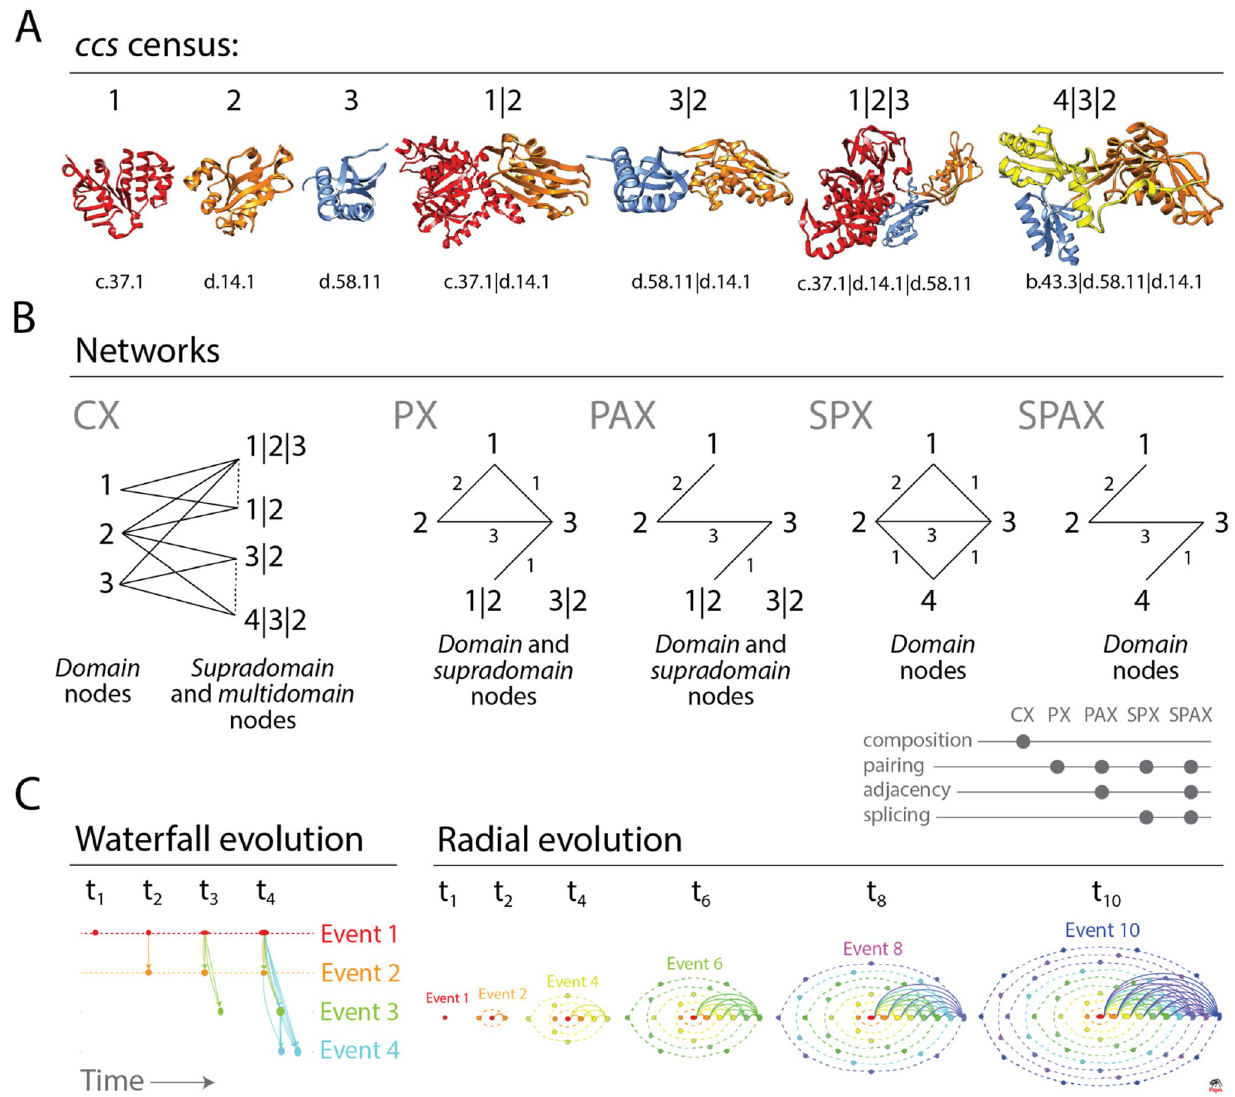
Figure 1. Networks of protein domain organization. ( A ) The genomic census of structural domains and their combinations defines SCOP concise classification string ( ccs ) descriptors of domains, supradomains and multidomains that are building blocks of networks. We illustrate the census with a sample from the entire entity set, comprising of 3 domains (1, 2 and 3), 2 supradomains (1|2 and 3|2) and 2 multidomains (1|2|3 and 4|3|2) that are common in dehydratase enzymes and elongation factors. ccs identifiers of structural domain constituents defined at fold superfamily (FSF) level are listed below the atomic models visualized in ribbon format with Chimera. ( B ) Five operative criteria for network generation capture the interactions among protein architecture nodes as networks grow in evolution. CX is a partial bipartite network (projection-decomposable) that connects domain nodes to supradomain and multidomain nodes (which can connect to each other; hatched links) when present in multidomain proteins. PX connects domain and supradomain nodes when multidomain proteins are ‘decomposed’ into pairs of architectures, regardless of topological constraints. PAX borrows the PX criterion but respects topological constraints. SPX connects domain nodes spliced from architectures when domain pairs are present in proteins. SPAX connects domain nodes when adjacent domain pairs are present in proteins. ( C ) Chronological development of evolving networks. In ‘waterfall evolution’ layout, time progresses from left to right as ‘discrete events’ of network evolution progressively unfold the appearance of nodes and links (time-directed arrows known as arcs) from top to bottom, colored according to their age. Arc multiplicities describe link cardinality. Source-sink recruitments of architectures are visualized by horizontal and vertical elongations of node symbols, which describe their outdegree and indegree, respectively. As networks grow, the symbols of older nodes widen by outdegree accumulation, while those of younger nodes grow tall by indegree accumulation. In ‘radial evolution’ layout, the time-variant network grows by accumulating nodes in concentric rings (orbitals), each reflecting a time event. We illustrate radial evolution with 6 snapshots of a network growing to a size of 55 nodes as it unfolds from time t 1 to t 10 . Nodes (n) in orbitals (r) grow at r + 1 rate and only one node per orbital connects to single nodes in each of the other orbitals. Thus, outward links (o) of an orbital are o = t–r–1, where t is the current time. Inward links (i) of an orbital are i = t–o–1 = r. Finally, total links of a network at any time are t(t − 1)/2. The width and height of symbols represent the outdegree and indegree of nodes, respectively. Symbol sizes are shifted by 10 for a better visualization of